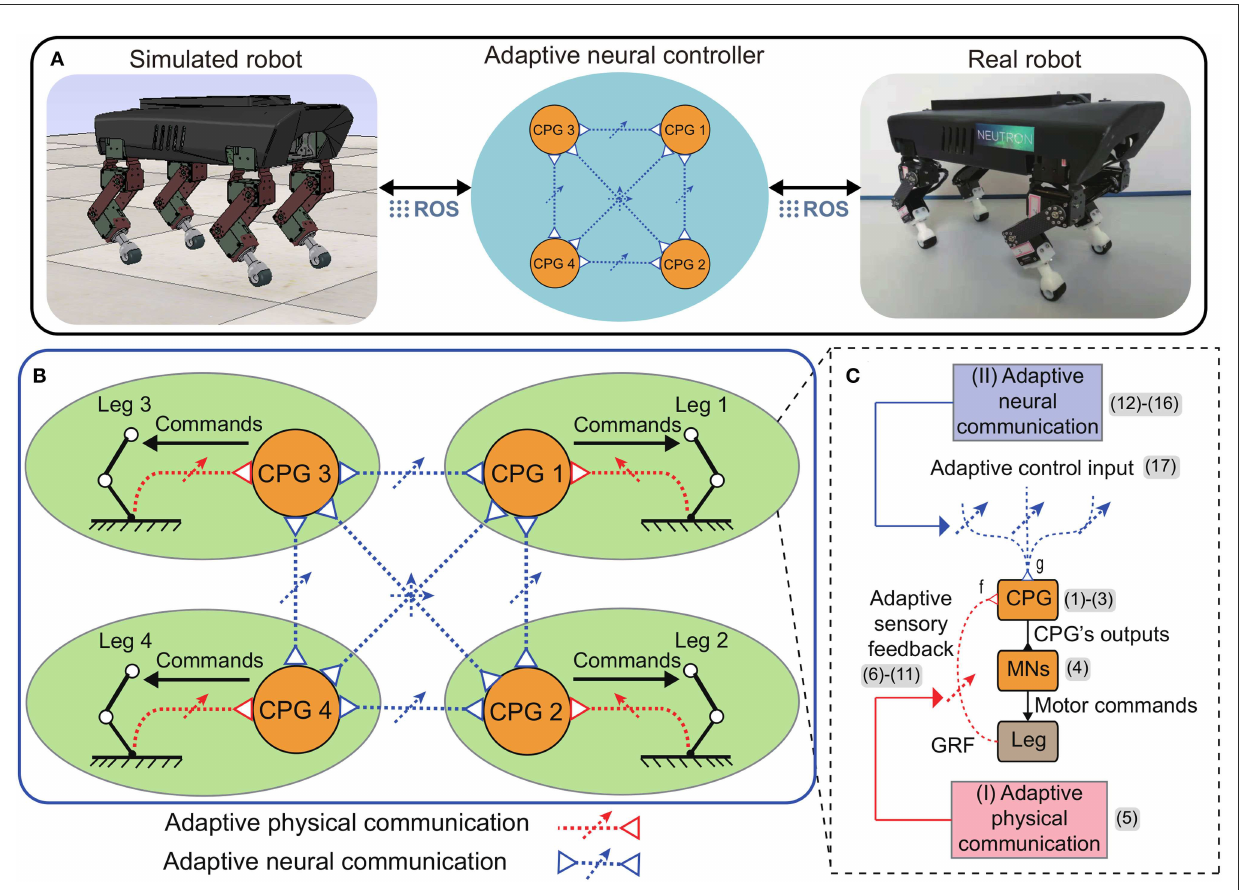
FIGURE1 (A) Overview of the adaptive neural control implemented on a quadruped robot in both simulation and real world (see the Supplementary material for more details of the simulated and real robot setups). (B) The control is based on decoupled CPG-based control circuits and the adaptive physical and neural communications (APC and ANC). The number (1–17) represent the equation numbers. (C) The main ingredients of each local CPG-based control circuit includes a SO(2) CPG (Pasemann et al., 2003) to produce rhythmic signals, motor neurons (MNs), and two adaptive modulation mechanisms (adaptive sensory feedback and adaptive control